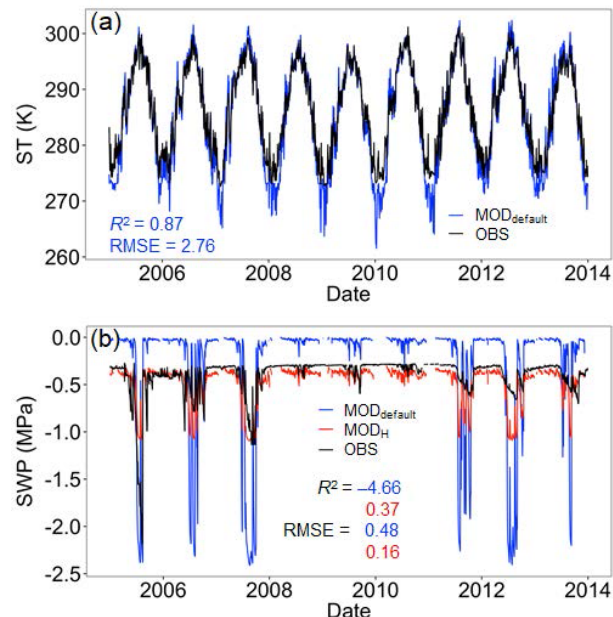
Figure 3. Daily ST and SWP at 10cm. Blue and red lines/dots are model outputs before (MOD default ) and after (MOD H ) soil water potential improvement, respectively. R 2 and RMSE are shown in corresponding colors. Extremely low SWP values due to frozen soil water are not